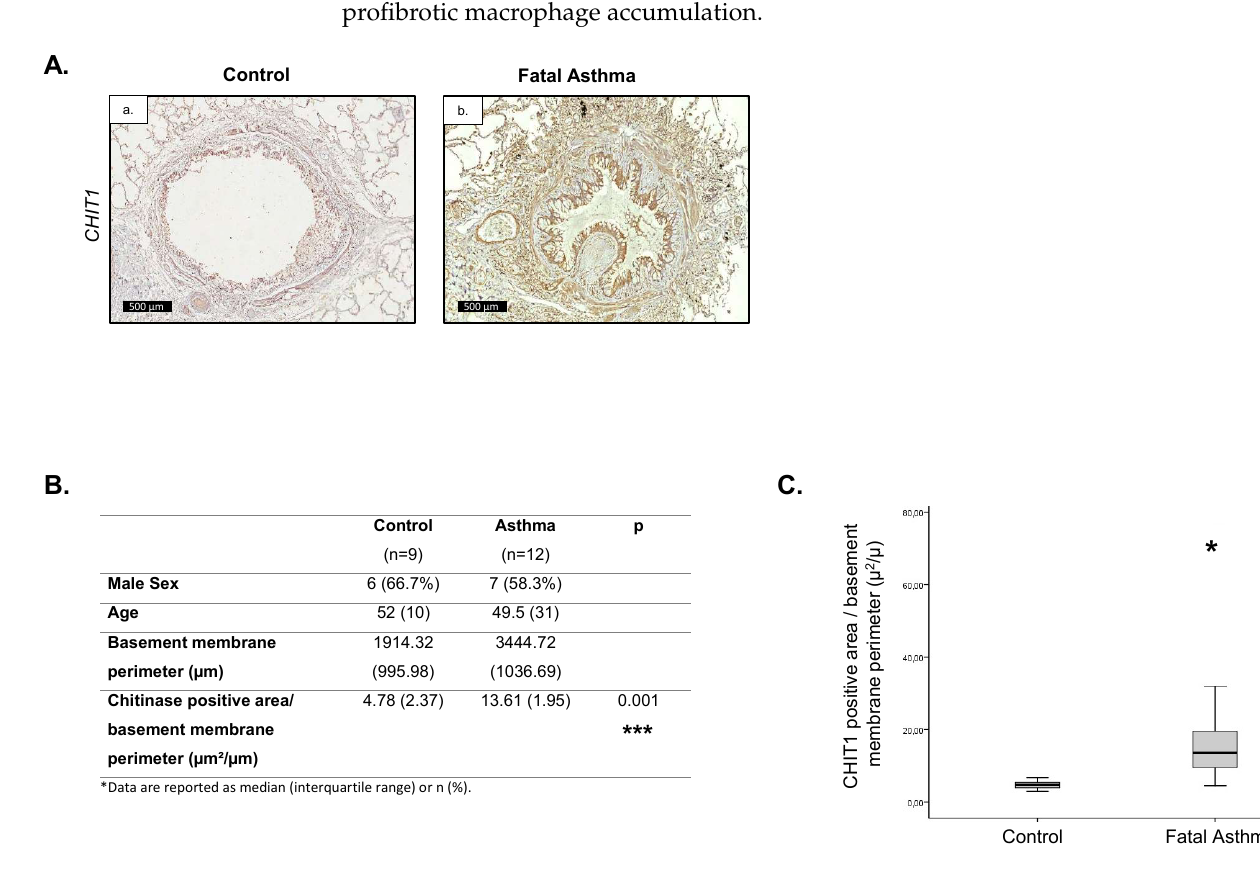
Figure 1. Increased contribution of CHIT1 in airway remodeling in fatal asthma patients. ( A ) Repre- sentative immunohistochemical staining of CHIT1. ( B ) Table containing donor and fatal asthmatics characteristics, basement membrane perimeter lengths, and CHIT1-positive area/basement mem- brane perimeter ratios ( µ 2 / µ ). ( C ) Quantitative representation of CHIT1-positive area/basement membrane perimeter ratios ( µ 2 / µ ) in the lungs of donors and fatal asthma individuals. Data pre- sented as mean ± s.e.m. p -values < 0.05 were considered as statistically significant and presented as * for p < 0.05 and *** for p <